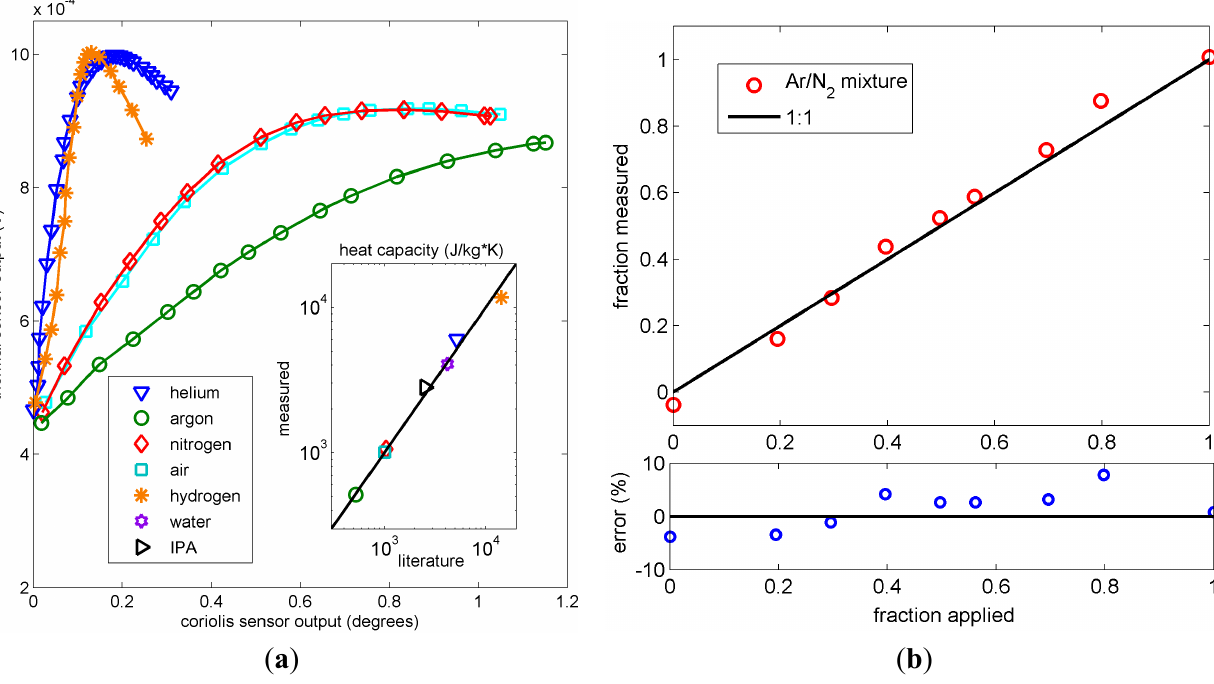
Figure 5. ( a ) Thermal flow sensor output as a function of the Coriolis sensor output, figure inset shows the resulting measured heat capacity as a function of literature values ( b ) measured volume fraction of nitrogen in argon based on heat capacity